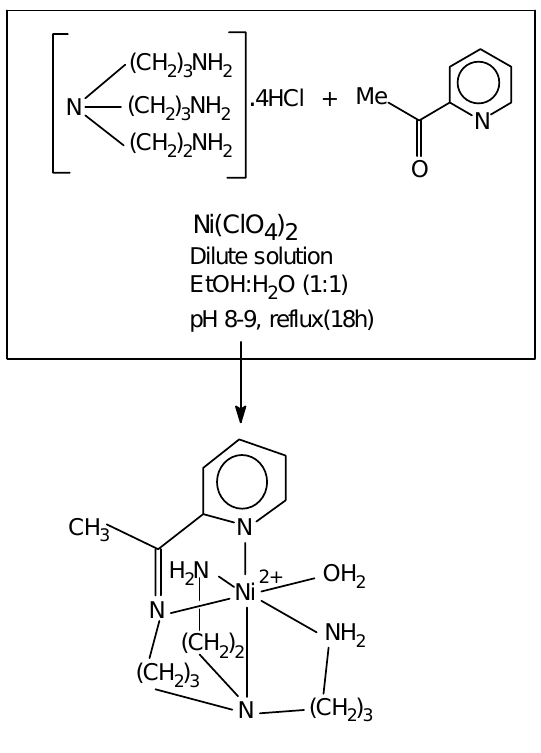
Figure 1. Outcome of the template condensation between 2-acetylpyridine and tripodal tetraamine (ppe) in the presence of nickel(II)